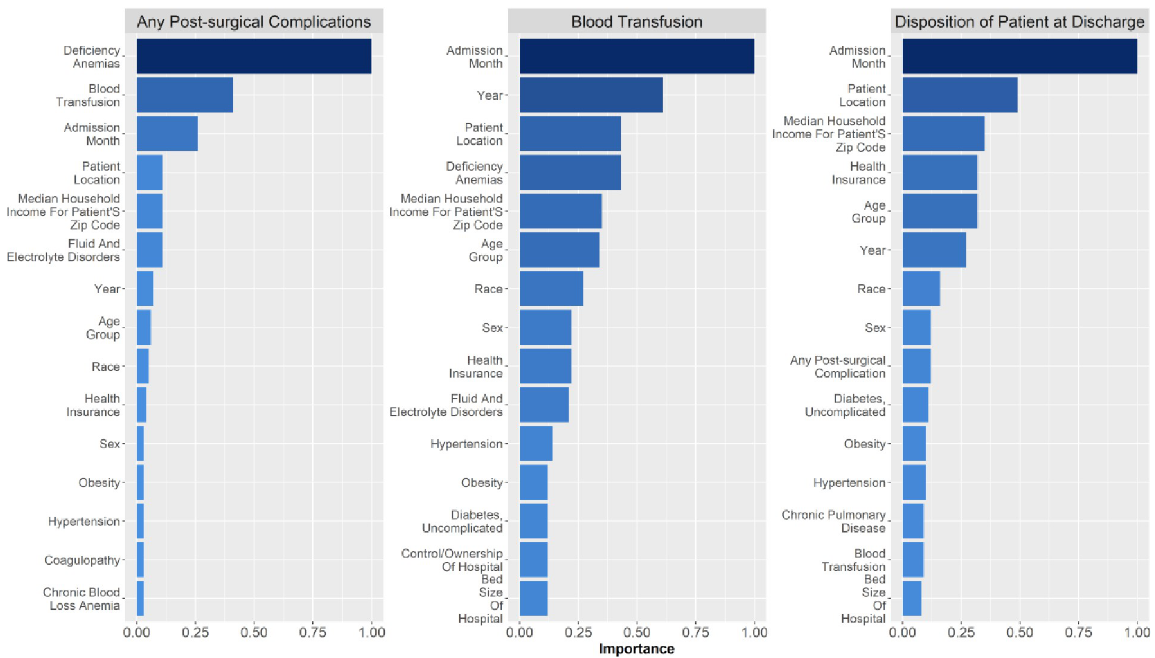
Fig 3. Relative importance of the predictor variables in the GBM predictive